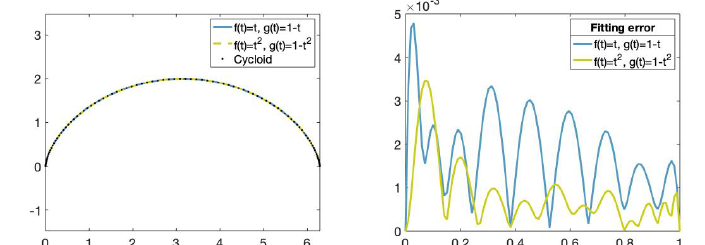
Figure 10. (Left) : Set of data points on the cycloid (dotted), fitting curve obtained using the functions f ( t ) = t , g ( t ) = 1 − t , t ∈ [ 0,1 ] (blue) and fitting curve obtained using the functions f ( t ) = t 2 , g ( t ) = 1 − t 2 , t ∈ [ 0,1 ] (green). ( Right ): Fitting error comparison.The x -axis represents the parameters t in [ 0,1 ] and the y -axis represents the fitting error value of the fitting curves obtained using the functions f ( t ) = t , g ( t ) = 1 − t , t ∈ [ 0,1 ] (green) and the functions f ( t ) = t 2 , g ( t ) = 1 − t 2 , t ∈ [ 0,1 ] (blue).